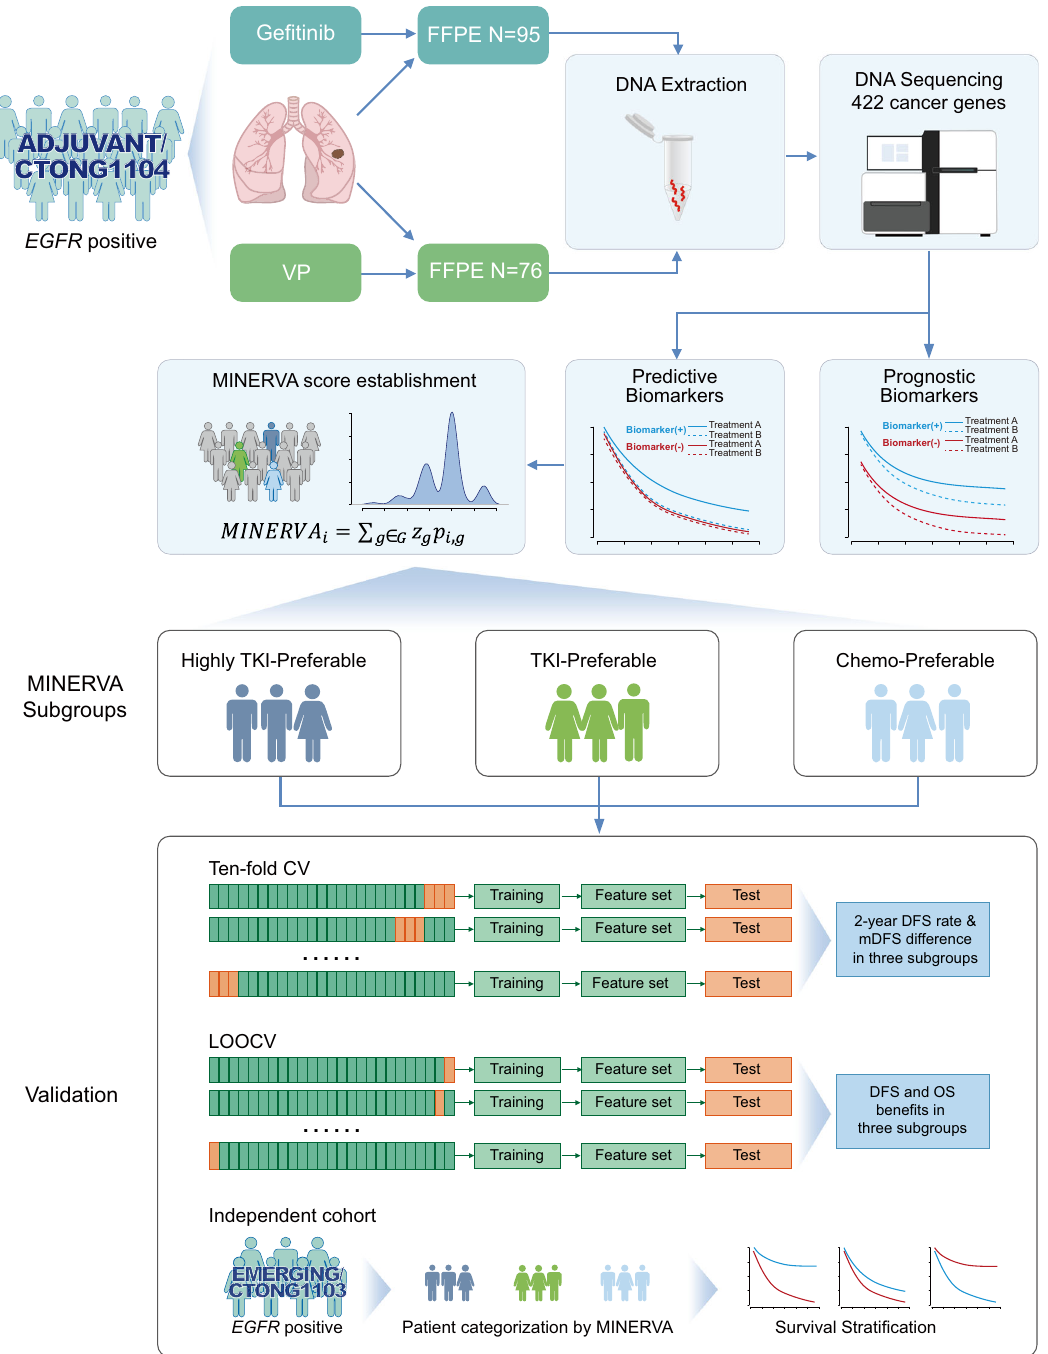
Fig. 1 Schematic diagram of patient screening, sample collection, and methodology for developing the clinical predictive model. Formalin- fi xed paraf fi n- embedded (FFPE) samples of patients treated with adjuvant ge fi tinib or intravenous vinorelbine plus cisplatin (VP) in the ADJUVANT trial were collected for NGS-sequencing. Genomic alterations were analyzed for being predictive or prognostic biomarkers for adjuvant treatment. Predictive markers were selected to develop the Multiple-gene INdex to Evaluate the Relative bene fi t of Various Adjuvant therapies (MINERVA) score and validated through ten- fold cross validation (CV) or leave-one-out CV (LOOCV) procedures and an independent